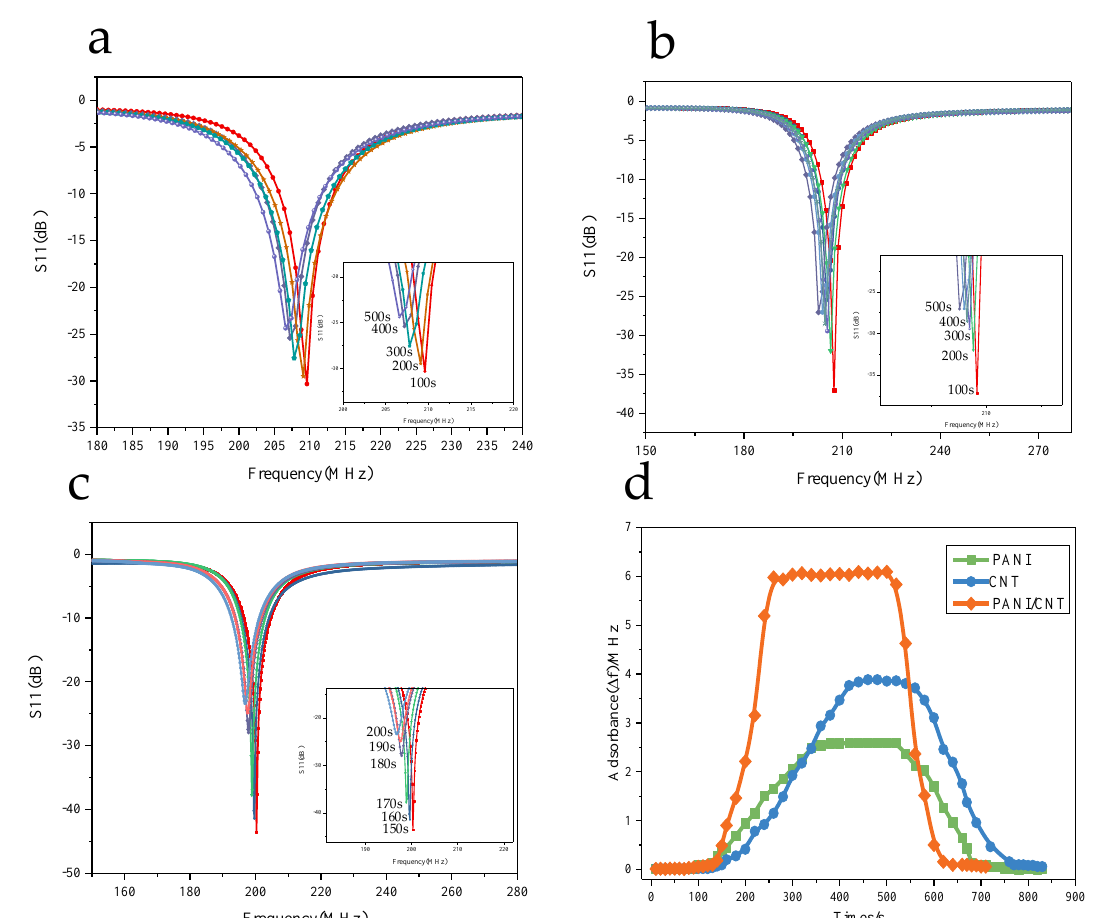
Figure 10. Adsorption performance of different materials for ammonia: ( a ) The data when PANI adsorbs ammonia to the stable state, with the maximum frequency variation being 2.5 MHz; ( b ) The data when CNT adsorbs ammonia to the stable state, with the maximum frequency variation being 3.9 MHz; ( c ) The data when PANI/CNT adsorbs ammonia to the stable state, with the maximum frequency variation being 6 MHz; ( d ) Adsorption capacity and response recovery time diagram. By comparison, we found that the sensor coated with PANI/CNT composites has better adsorption performance than the other two sensors, with the time for the adsorption and desorption of NH 3 gas molecules by the sensor being significantly shortened.